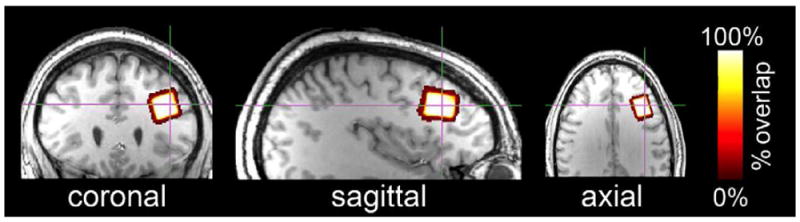
Orthonormal slices of 3D geometric voxel overlap (n = 24) in template
space are depicted.